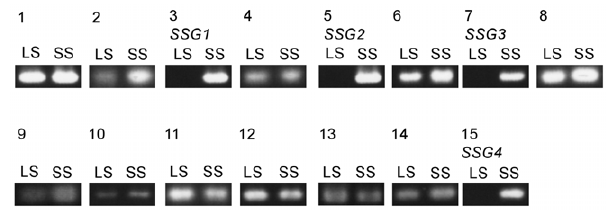
Figure 2. Expression of genes selected by in silico subtraction as determined by RT-PCR. The expression of genes corresponding to the 15 contigs selected by in silico subtraction was examined by RT- PCR using cDNA from long styles (LS) and short styles (SS) as templates. See Table S1 for RT-PCR primers.